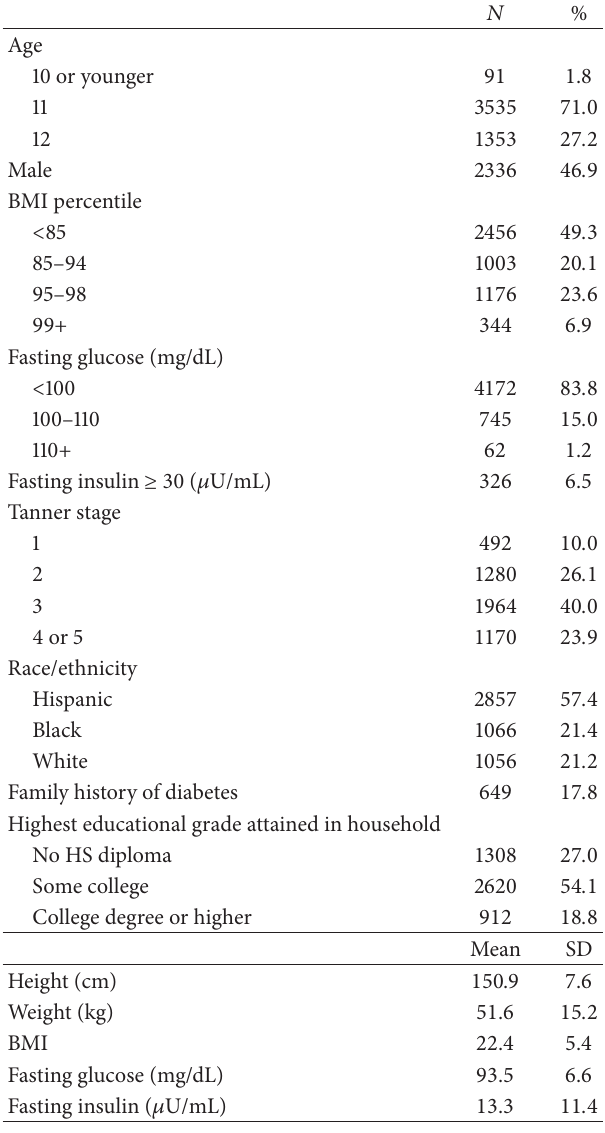
Table 1: Clinical and demographic characteristics of HEALTHY study